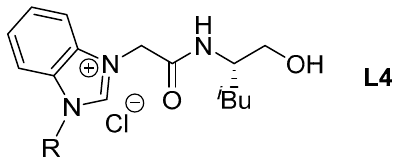
Figure 6. Previously reported chiral ligand L4 .